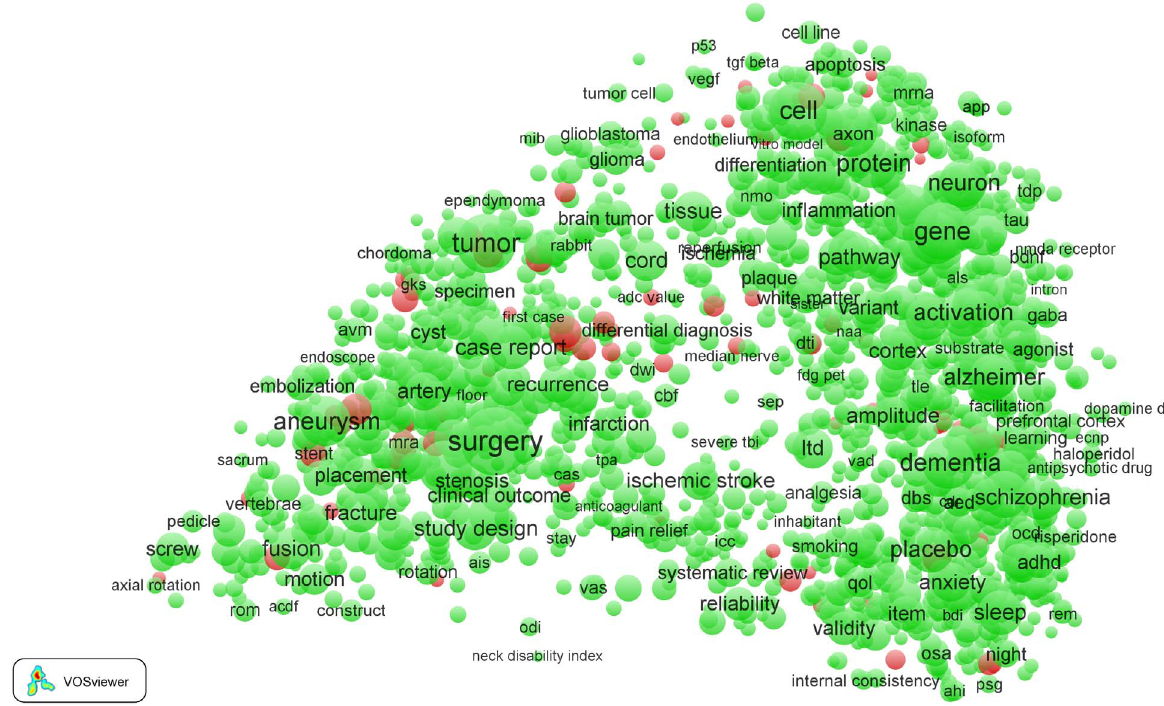
Figure 2. Term map of the Clinicalneurology field. EPS-related terms are colored red. All other terms are colored green. doi:10.1371/journal.pone.0111530.g002 PLOS ONE |